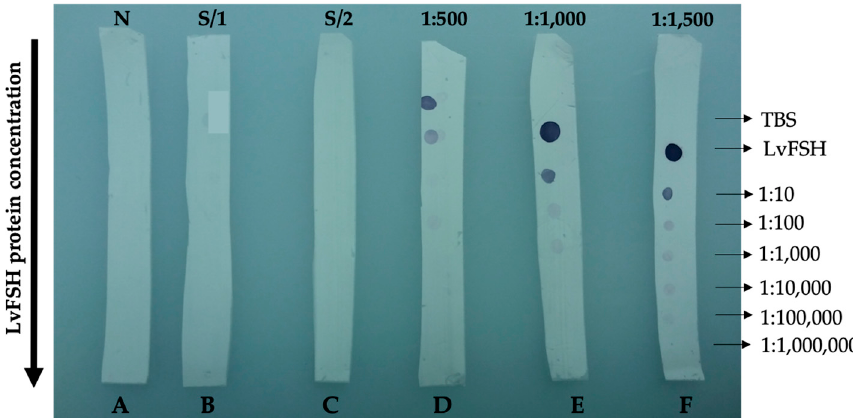
Figure 7. Anti-LvFSH titer by dot-blot assay. A, B, C controls: no antibody (N); B and C: without first (S/1) and second antibody (S/2), respectively; D, E, F, dilution 1:500, 1:1000 and 1:1500 of the obtained anti-LvFSH and purified by protein A chromatography. A total of 2 µ L of diluted LvFSH protein solution was applied in descending order: C, 0.228 mg/mL, and a serial dilution (1:10 to 1:1,000,000) and Tris saline buffer (TBS) as control.